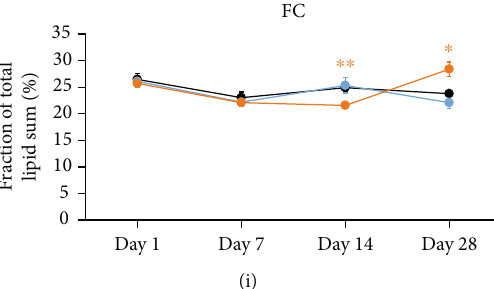
Figure 4: Regulation of membrane lipids during osteogenic di ff erentiation of DFCs. DFCs were cultured in osteogenic di ff erentiation medium (ODM), BMP2 di ff erentiation medium, or control medium (DMEM) for one, seven, 14 and 28 days before the lipidome was analyzed by MS. This fi gure shows the regulation of total lipids (a) and the fraction of phosphatidylethanolamines (PE, b), phosphatidylcholines (PC, c), phosphatidylinositols (PI, d), phosphatidylserines (PS, e), phosphatidylethanolamine-based plasmalogens (PE P, f), phosphatidylcholine-ethers (PC O, g), sphingomyelins (SM, h), and free cholesterol (FC, i). Data points show means ± standard deviation , and Student ’ s t -test was performed to compare di ff erentiation medium with control medium at the same time point. ∗ p < 0 : 05 , ∗∗ p < 0 : 01 , ∗∗∗ p < 0 : 001 . Asterisks relate to the di ff erentiation medium with data points and line in same